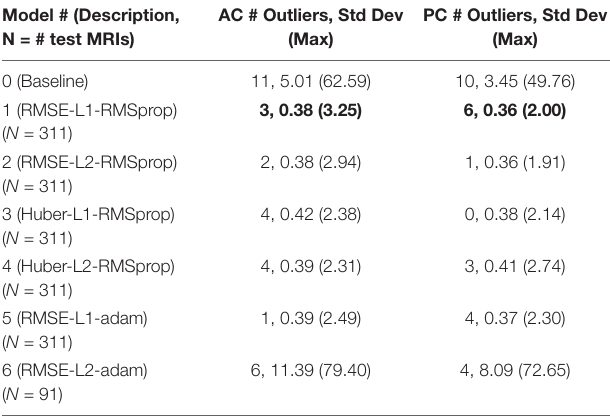
FIGURE 5 | Boxplots of localization errors achieved, measured in millimeters, by the baseline and DeepNavNet models 1-6. Statistical analysis of the baseline and Models 1-5 were conducted using all of the test data ( N = 311), whereas Model 6 was evaluated using a subset ( N = 91). Box whiskers span 1.5 times the interquartile range (IQR) in both directions. The 95% confidence interval spans 1.57 times the IQR / notches indicate significant differences between models, and asterisks indicate p -values < < 0.001 relative to baseline error. (A) Boxplots for AC localization errors. (B) Boxplots for PC localization